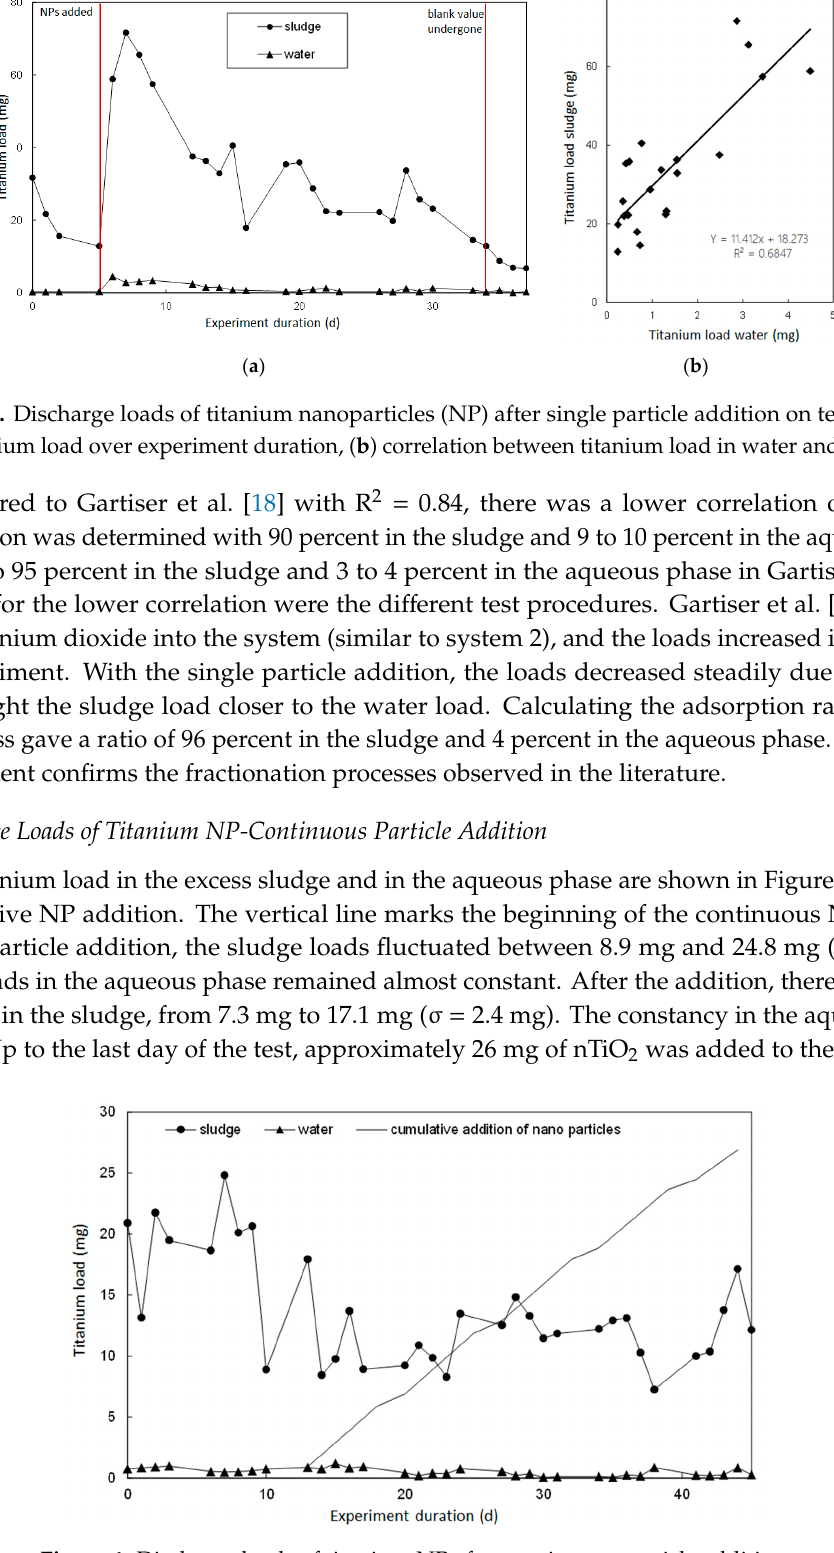
Figure 4. Discharge loads of titanium NP after continuous particle addition.